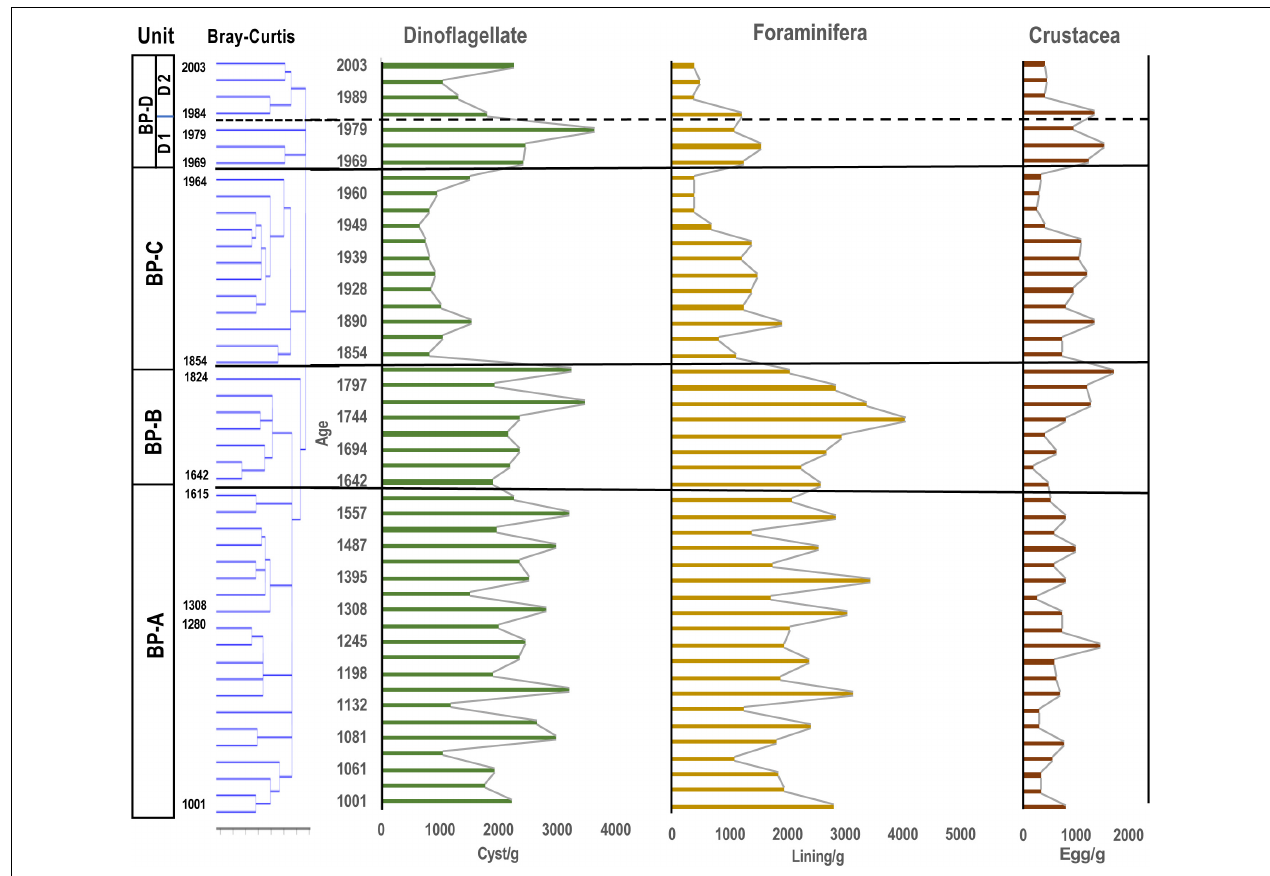
FIGURE 3 | Stratigraphic distribution of major aquatic palynomorphs (dinoflagellate cysts, microforaminiferal linings and crustacean resting eggs) observed in the core samples of Beppu Bay. Unit division in the left column based on the result for dinoflagellate cyst assemblages according to stratigraphic cluster analysis using Bray-Curtis